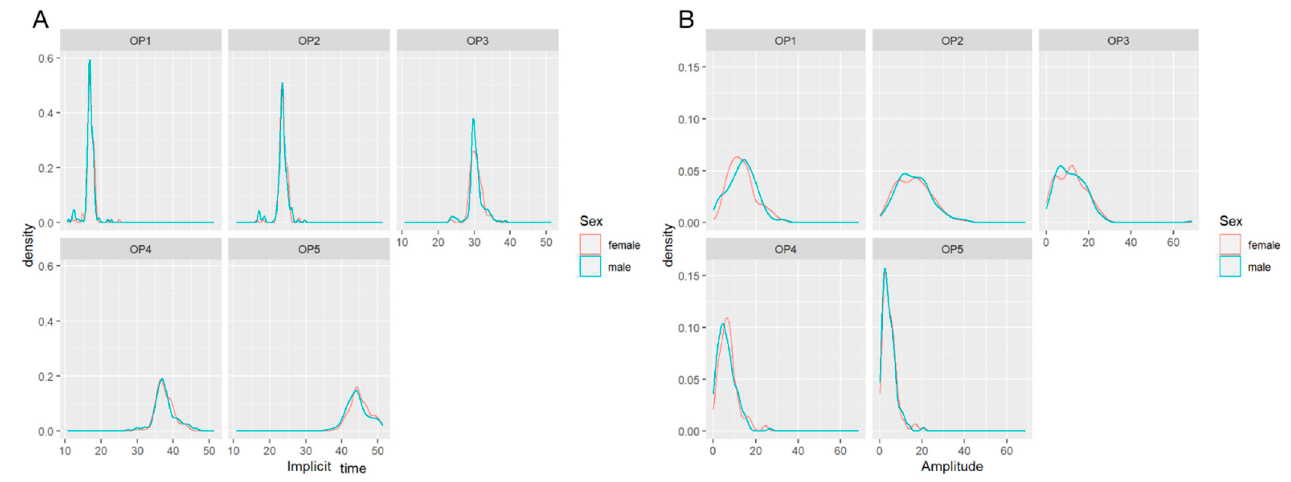
Figure 1. Relationship between implicit times ( A )/amplitudes ( B ) and gender of healthy children. There is no significant correlation between gender and the implicit times/amplitudes of the OP1-5.